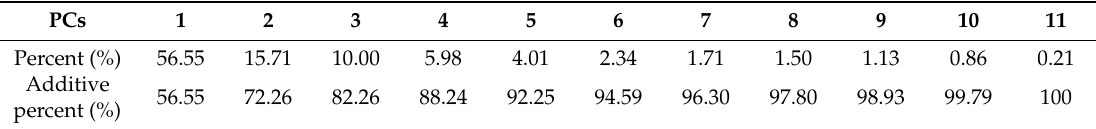
Figure 4. Percentages of process variance explained by principal components (PCs). Table 3. Percent and additive percent of process variance caused by PCs.